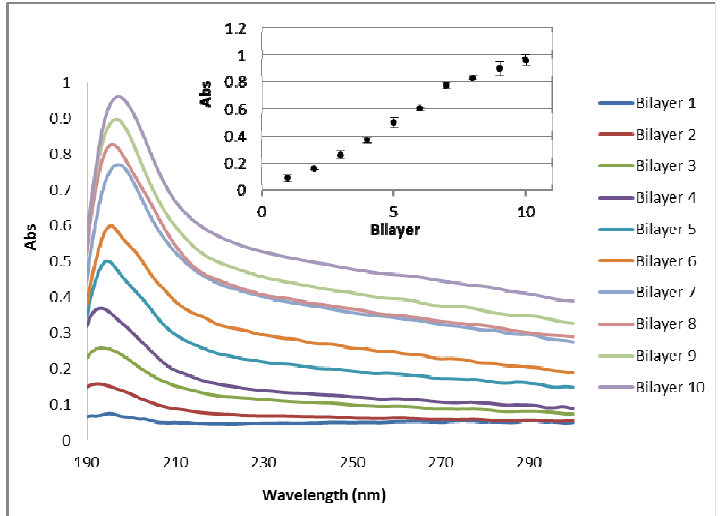
Figure 3. UV-Vis spectrophotometry analysis monitoring the growth of CHI/HA bilayers deposited by the original protocol. Growth was measuring by tracking the absorbance of CHI and HA between 190–220 nm. Three trials were done for each bilayer to account for minor compositional variances. An average of the three spectra is shown. Water rinse was for 5 s. Inset: Plot of the average absorbance ( N = 3) between 190–220 nm depicting the growth trend of the CHI/HA film. Error bars represent standard